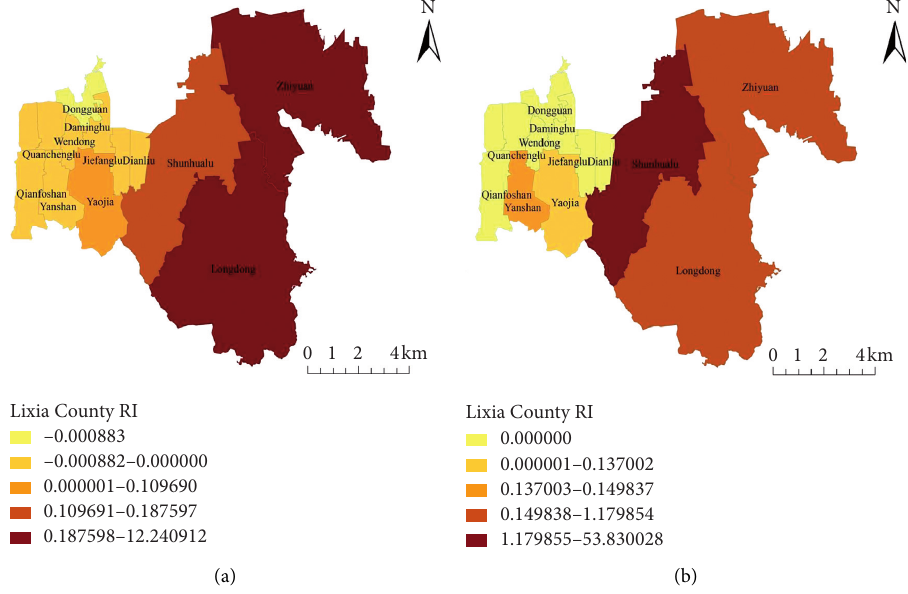
Figure 3: (a) Rurality intensity distribution of Lixia County in 2009. (b) Rurality intensity distribution of Lixia County in 2015.